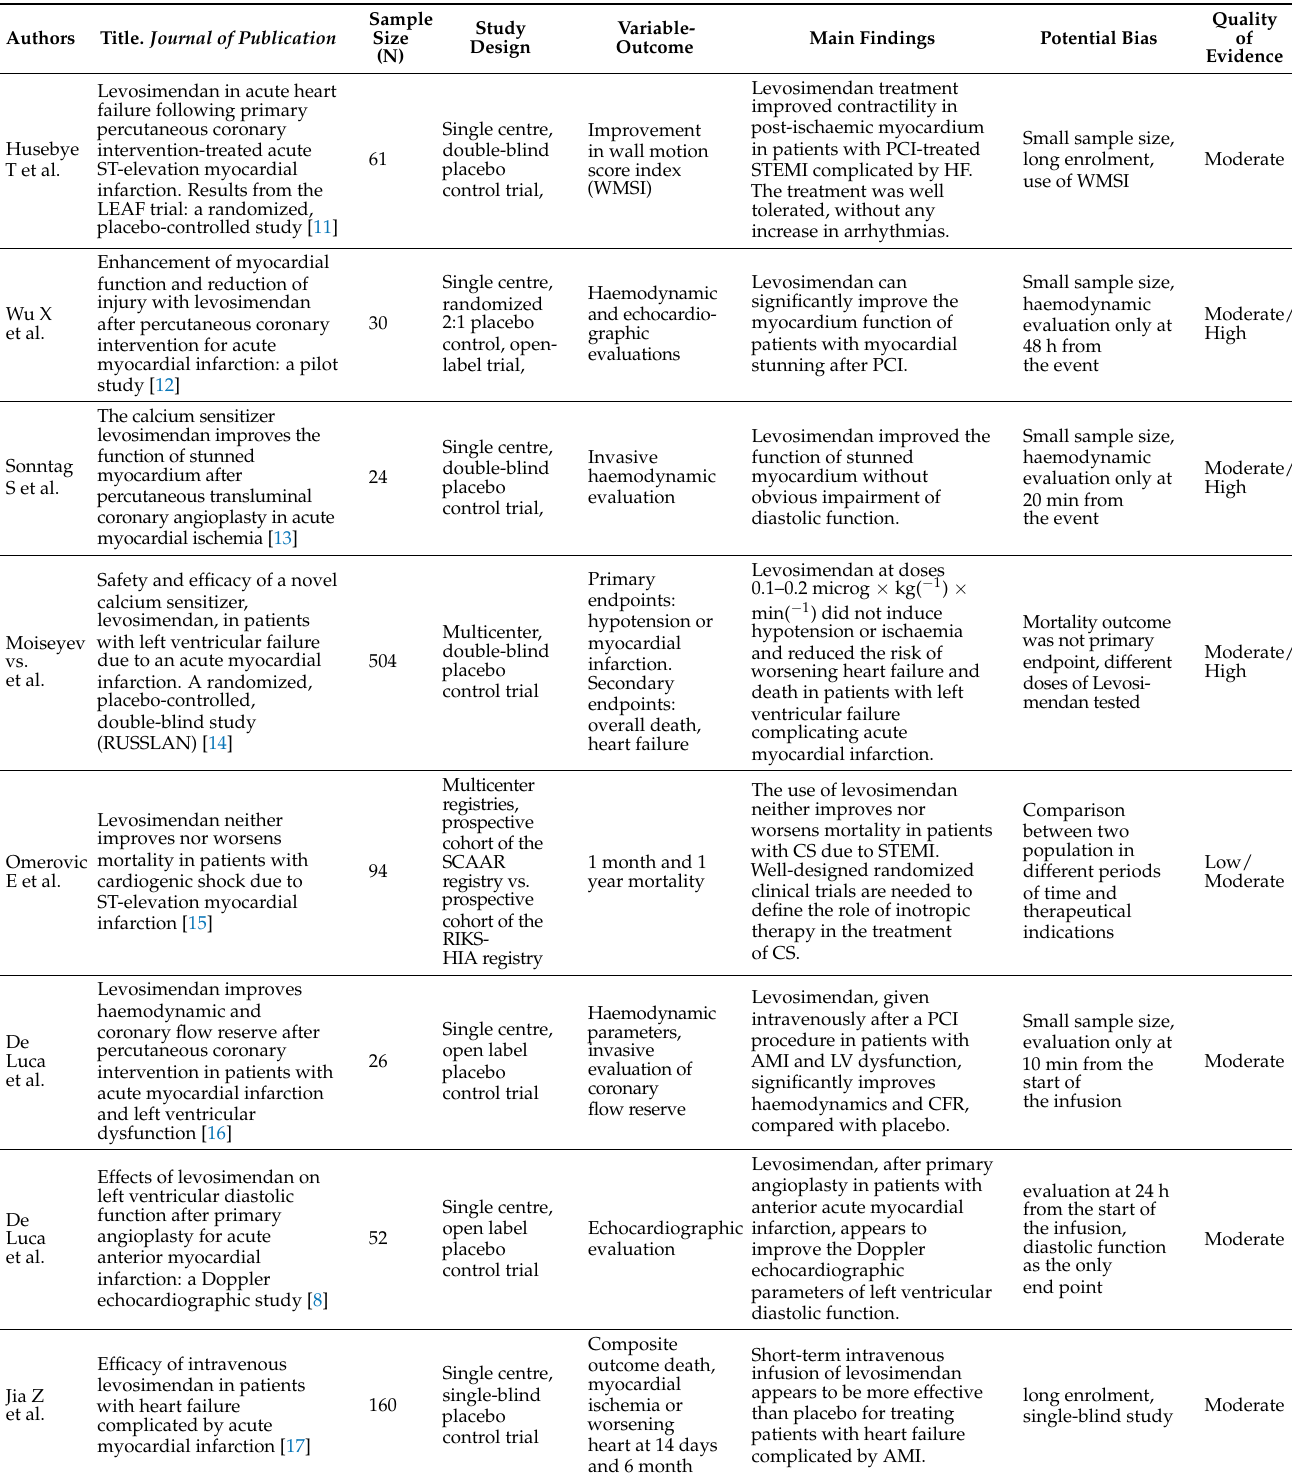
Table 2. Characteristics of Studies Involved in